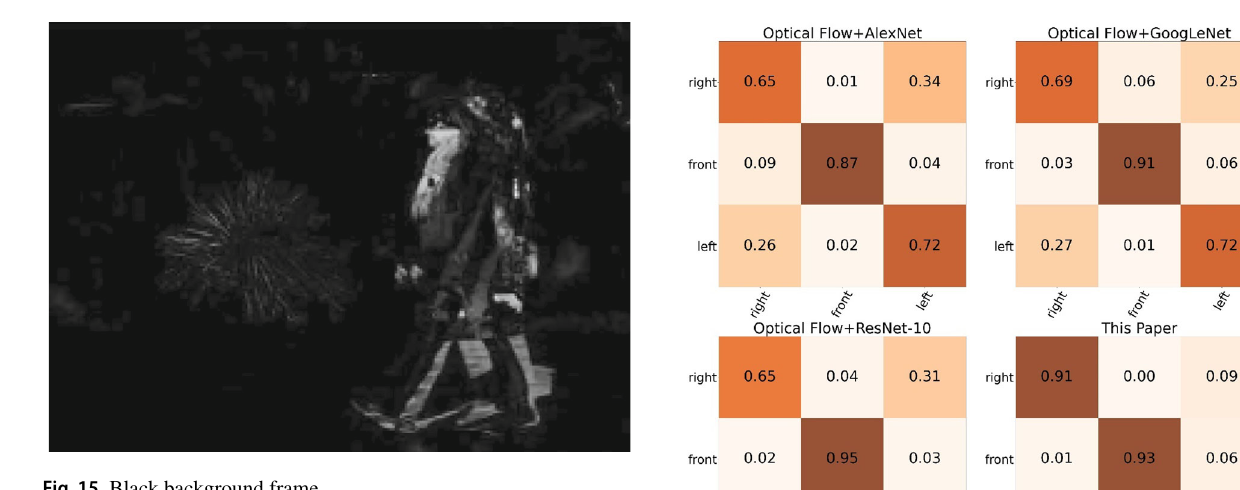
Fig. 15 Black background frame